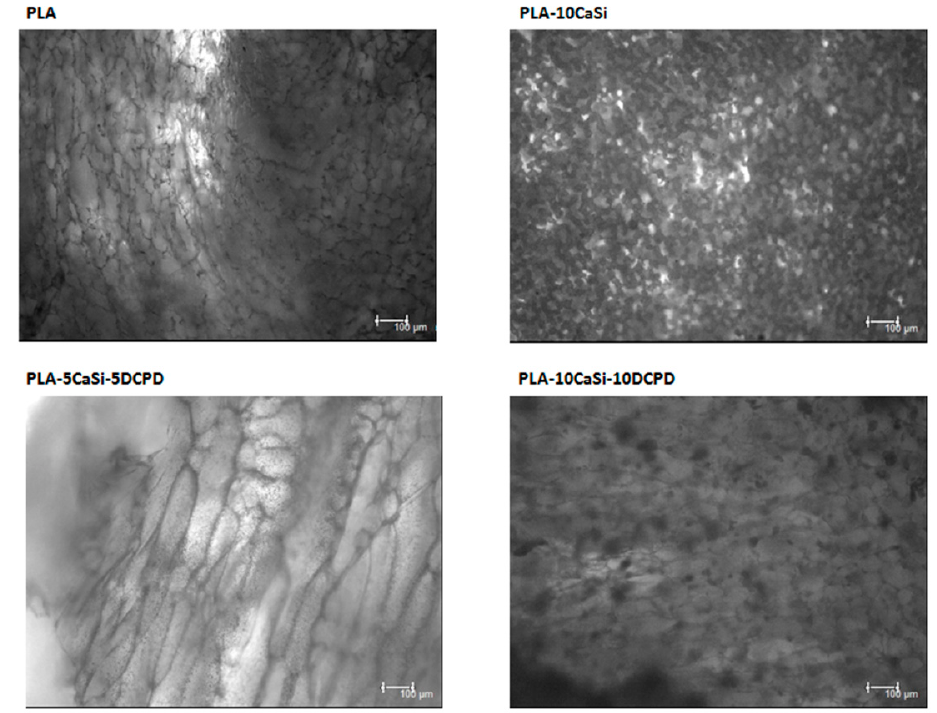
Figure 12. Comparison of different scaffolds microstructure in Bright Field (CLSM, 10 × magnification).